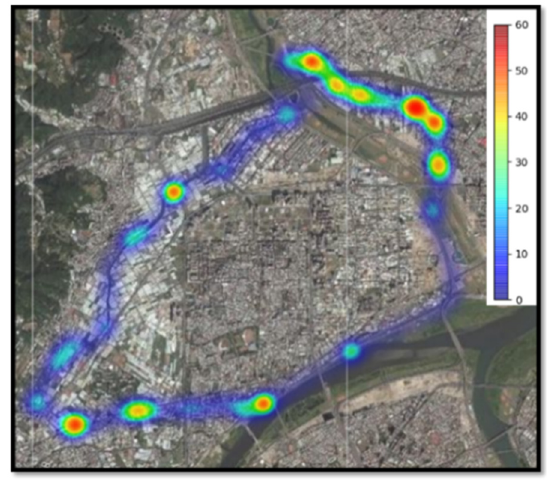
Figure 24. Measured pollutant concentrations at 11:00 P.M. on 14 February 2019.